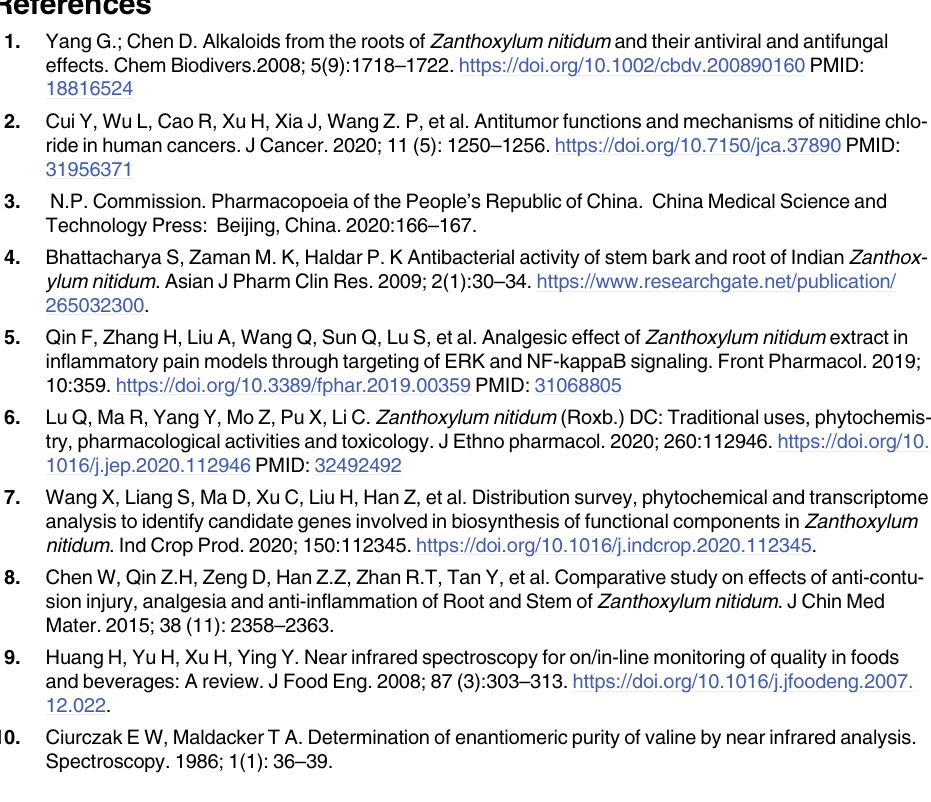
S1 Table. Habitats, types and the bioactive compound content of 147 Z . nitudum samples using ultra-high performance liquid chromatography and near infrared spectroscopy. S2 Table. Calibration curves of the five major bioactive constituents of Z . nitidum